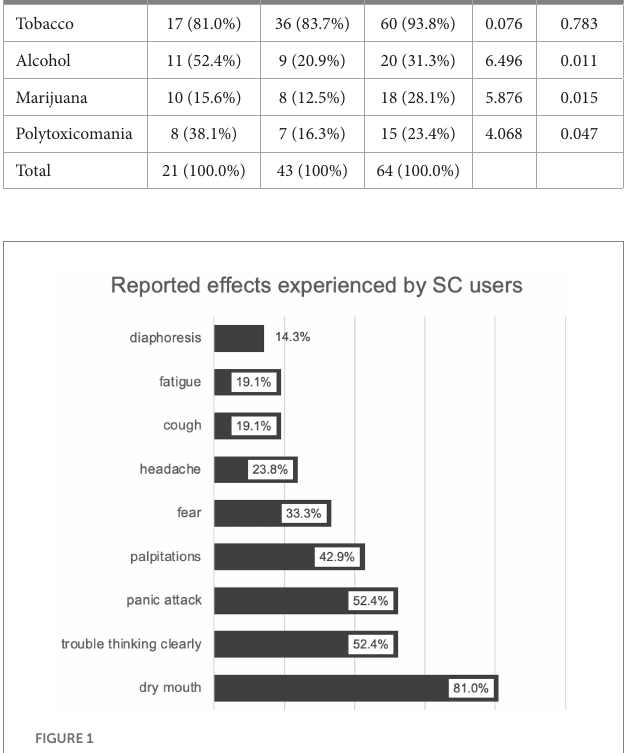
FIGURE 1 Reported adverse effects among SCs users ( N =